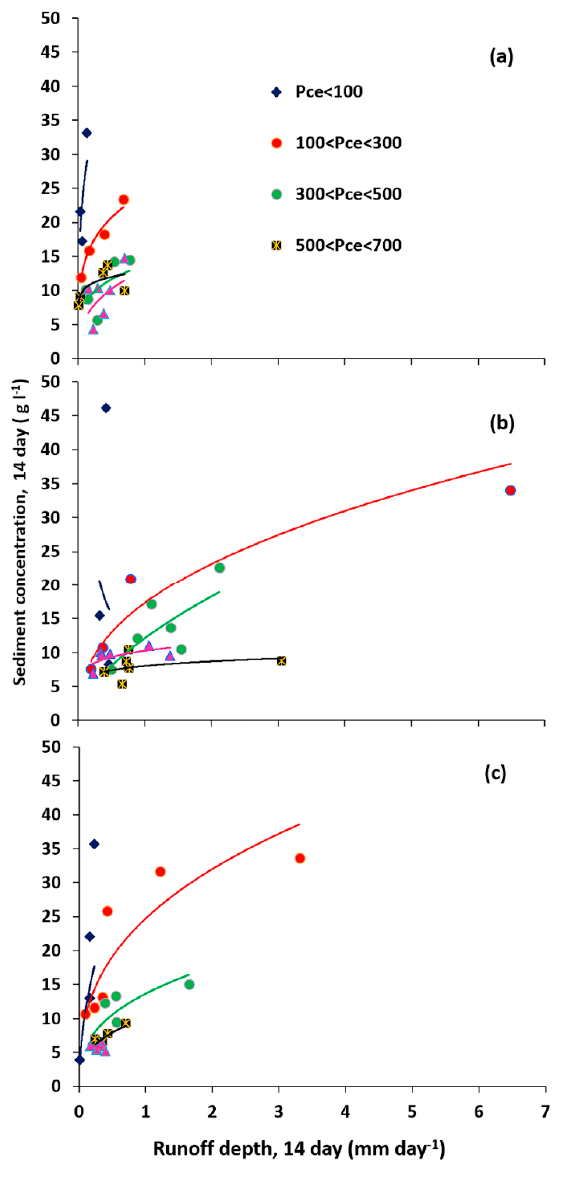
Figure 10. Fourteen-day averaged storm suspended sediment concentration and runoff depth for the ( a ) forested, ( b ) agricultural, and ( c ) entire Gomit watershed. The regression lines have the same colors as the symbols.